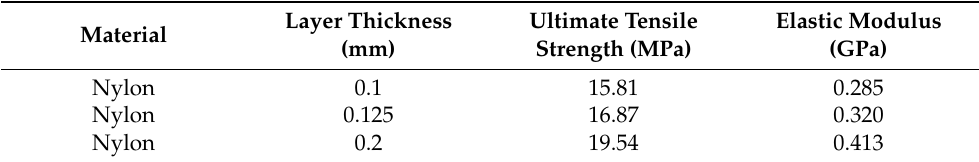
Table 3. Effect of layer thickness on ultimate tensile strength and elastic modulus of nylon.